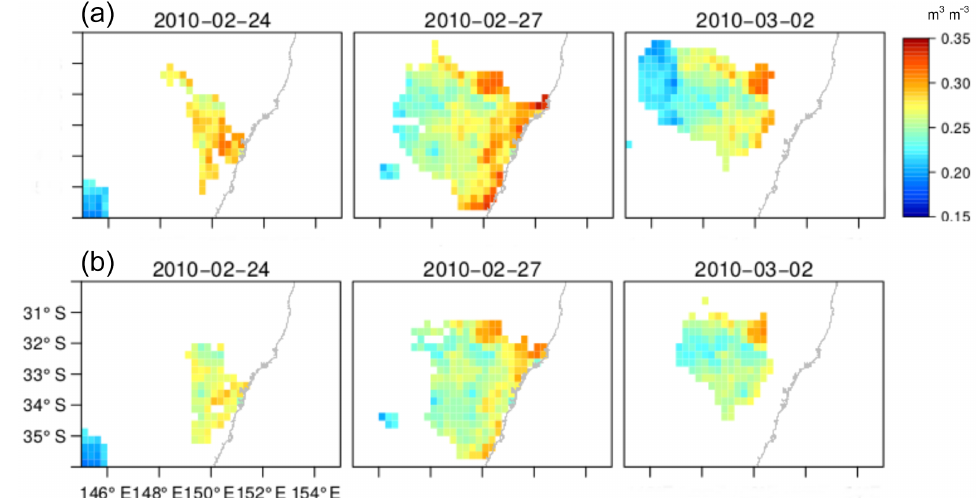
Figure 13. Dry period in February 2010, showing only the root-zone soil moisture below the 10% quantile level for the open loop (a) and experiment DA 2 (b) . The different spatial extent and differences in soil moisture itself, depending on the dataset used, on three different days are clearly visible. The figure is centred around the central coast of New South